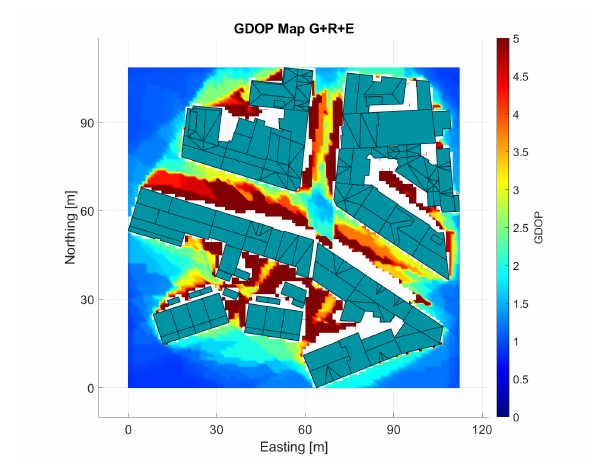
Figure 3. Typical example of the geometric dilution of precision (DOP, strength of the navigation geometry) in a multi GNSS positioning scenario (taking the current GPS, GLONASS and Galileo constellation) in an urban environment in Hannover. Small DOP values indicate good geometry. White spaces indicate regions without sufficient number of visible satellites. It should be noted that the situation changes significantly during the day.